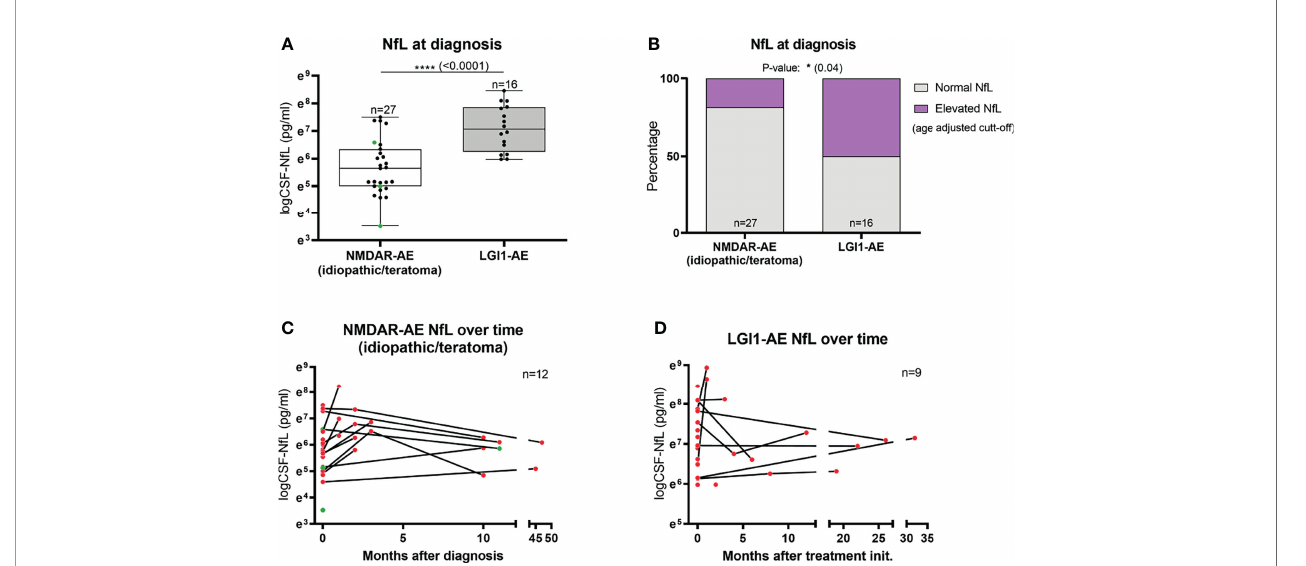
FIGURE 1 | CSF-Neuro fi lament light chain (NfL) levels at diagnosis and follow-up. CSF-NfL levels at diagnosis were higher in LGI1 patients than in patients with idiopathic/teratoma associated NMDAR-AE (A) . In addition, LGI1-AE patients more often presented elevated NfL levels at diagnosis, when using age-adjusted cut-off levels of CSF-NfL (B) . Twelve NMDAR-AE (out of 27) (C) and nine LGI1-AE patients (out of 16) (D) had follow-up NfL measurements available. Idiopathic/teratoma associated NMDAR-AE patients CSF-NfL levels decreased over time in majority of cases (C) . In contrast, LGI1-AE patients CSF-NfL levels were more heterogenous during follow-up (D) . Idiopathic/teratoma associated NMDAR-AE patients with teratomas are shown as green datapoints (A, C) . *p value < 0.05, ****p value <